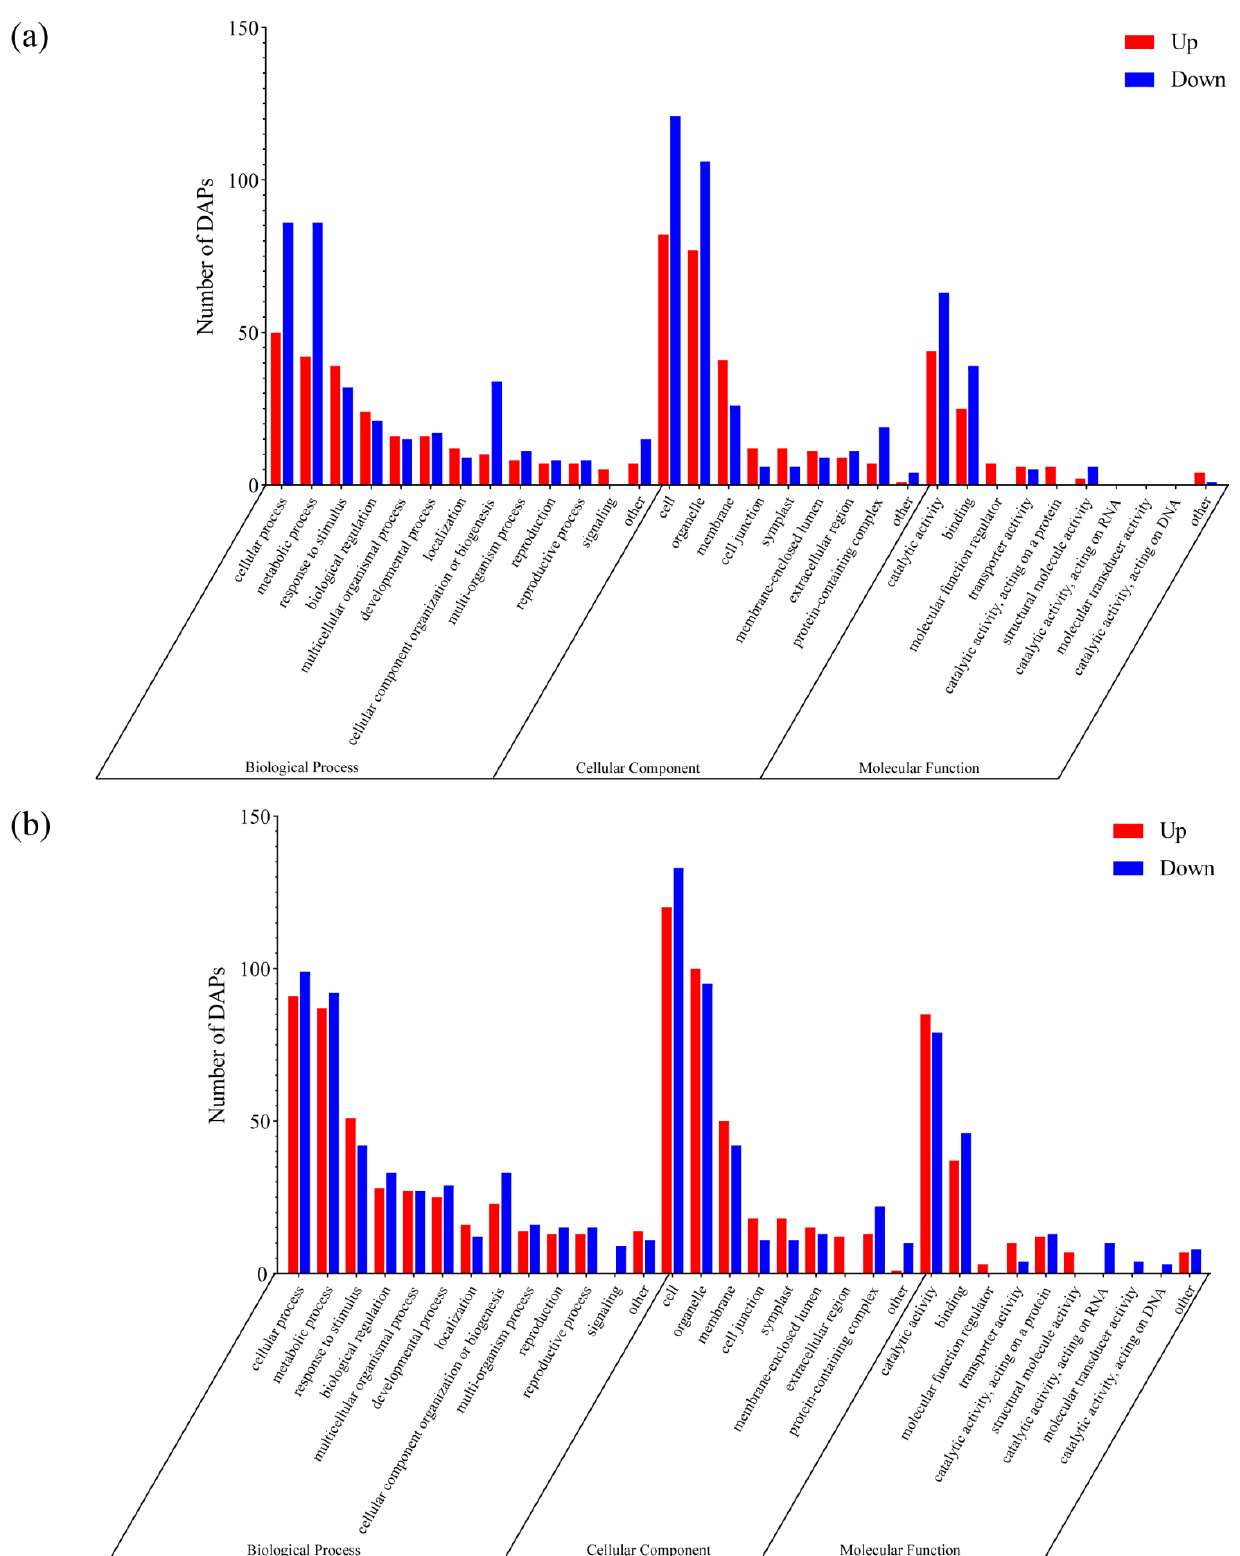
Figure 3. Gene ontology (GO) analysis of DAPs in pitaya stems under drought-stress conditions at 6 h ( a ) and 3 days ( b ). Red and blue bars represent upregulated and downregulated proteins, respectively. The enriched KEGG pathways among the DAPs revealed by the OS6H vs. NS6H and OS3D vs. NS3D comparisons are presented in Figure 4a,b. Among the DAPs in the OS6H